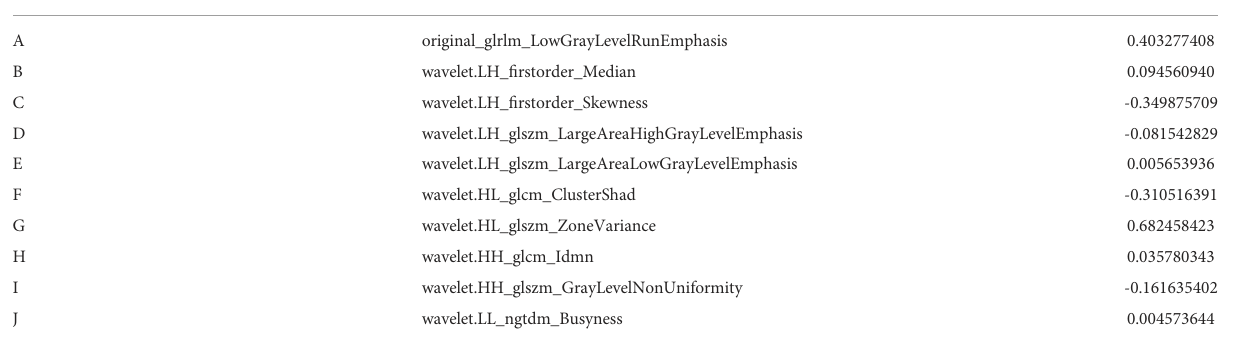
TABLE 4 Radiomics feature selection results.